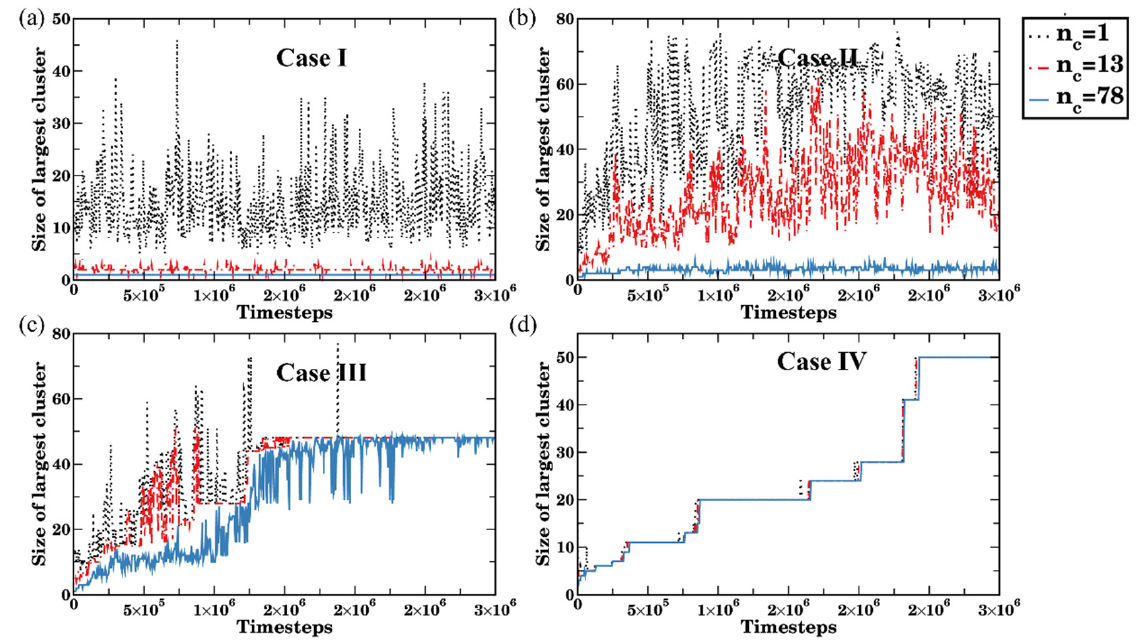
Figure 5. Time evolution of the size of the largest cluster size (number of bottlebrushes) in various solvents: ( a ) a sc-sol = 78 (Case I), ( b ) a sc-sol = 83 (Case II), ( c ) a sc-sol = 84 Case (III), and ( d ) a sc-sol = 89 (Case IV). Black dotted, red dash-dotted, and blue solid lines of the same color represent the number of contacts used to identify clusters (n c = 1, 13, and 78, respectively).